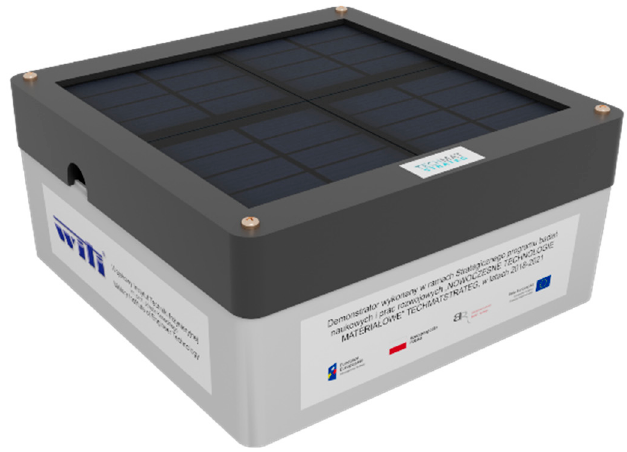
Figure 2. Photograph of a constructed demonstrator of an energy storage system based on silicon solar cells and supercapacitors [19].